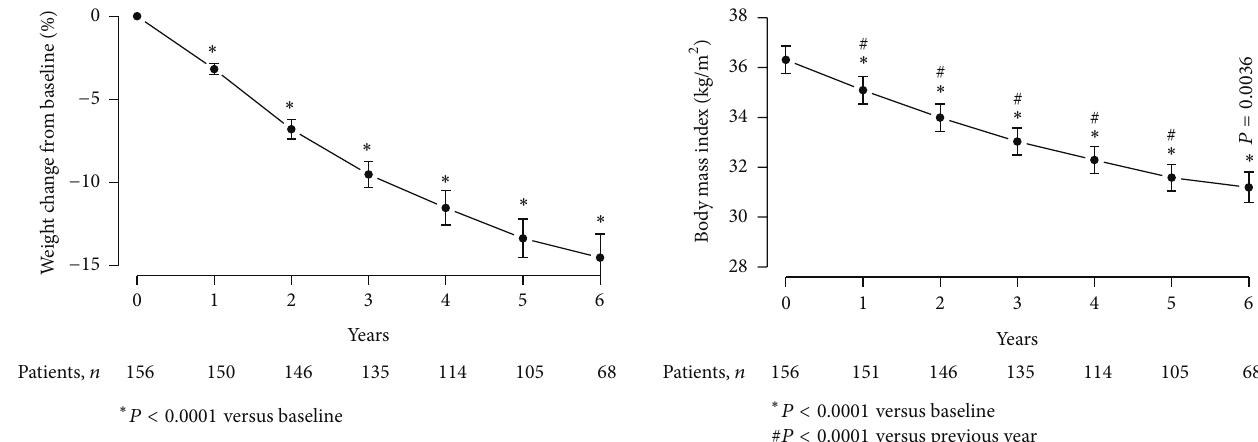
Figure 4: Body mass index (BMI, kg/m 2 ) in 156 obese hypogonadal men with type 2 diabetes mellitus treated with testosterone unde- canoate injections for up to 6 years.